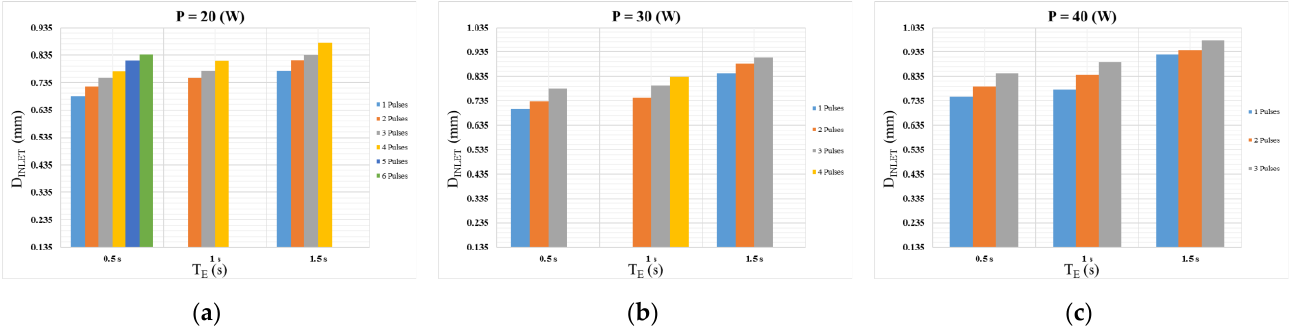
Figure 8. Influence of T E and N P on D INLET for 0.05 wt.% of CNPs and ( a ) P = 20 W, ( b ) P = 30 W and ( c ) P = 40 W.